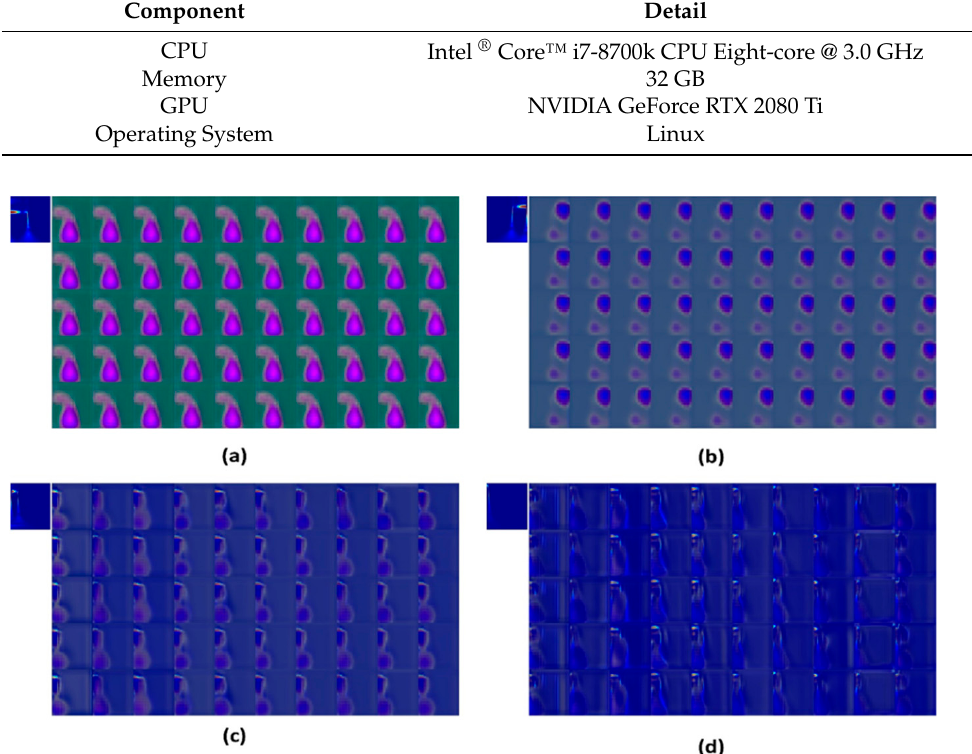
Figure 19. Latent images generated during the training process for the normal class ( a ) at 10,000 iterations for 30% speed, ( b ) 20,000 iterations 50% speed, ( c ) 30,000 iterations for 80% speed, and ( d ) 40,000 iterations for 100%